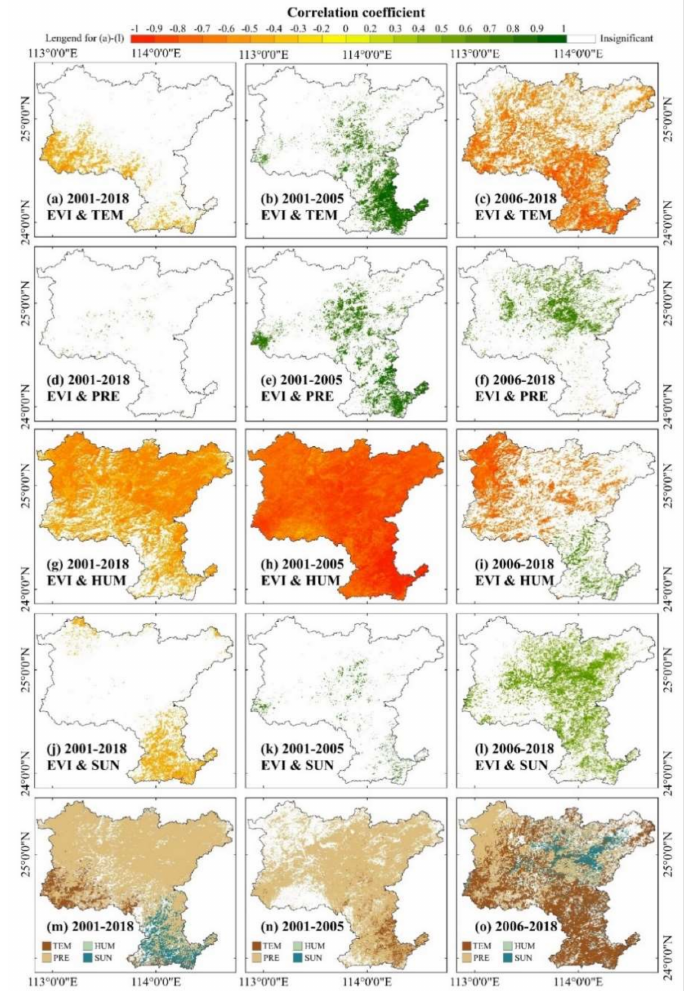
Figure 5. Spatial distribution of the correlation coefficients between the climate factors and EVI and the main climatic factor in different periods: study period from 2001 to 2018 ( a , d , g , j , m ), BTP ( b , e , h , k , n ), and ATP ( c , f , i , l , o ).